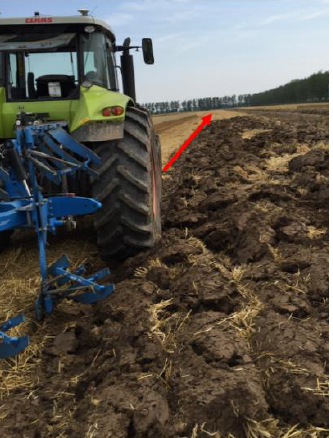
Figure 18. Tractor experiment diagram.